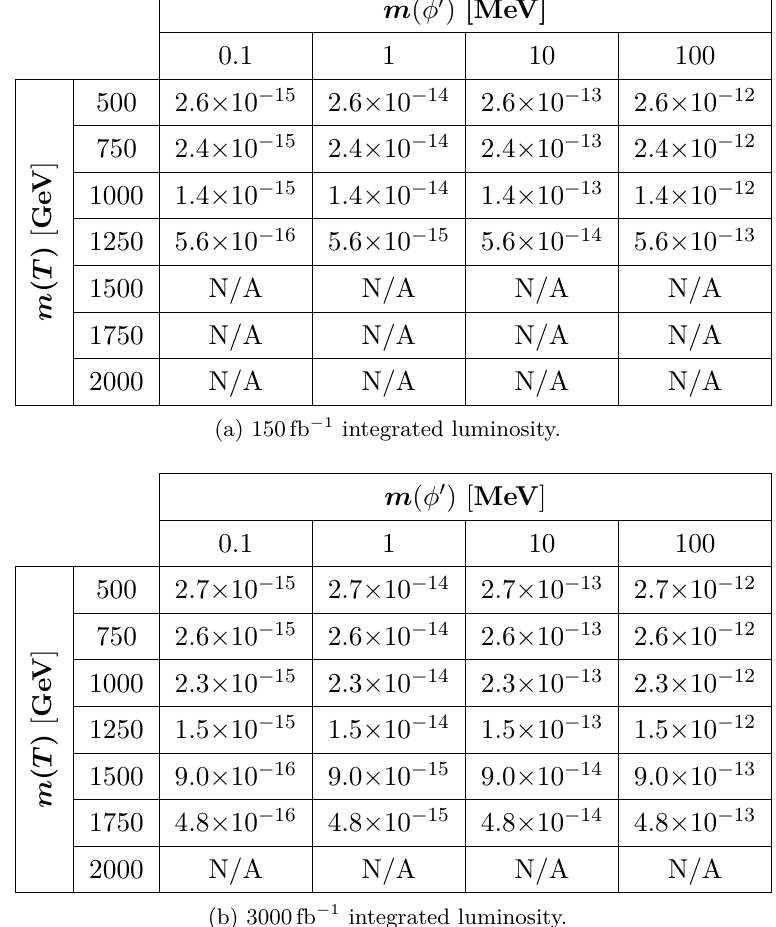
Table 2 . Longest lifetime of φ 0 [s] for which 5 σ discovery can be achieved. “N/A” indicates no 5 σ discovery is possible (due to small cross